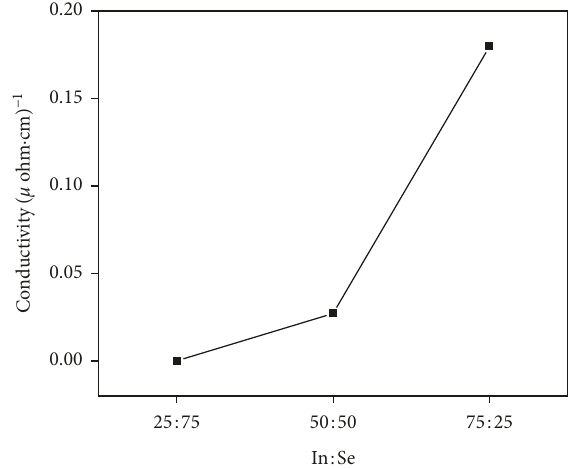
Figure 7: Variation in electrical conductivity with In:Se